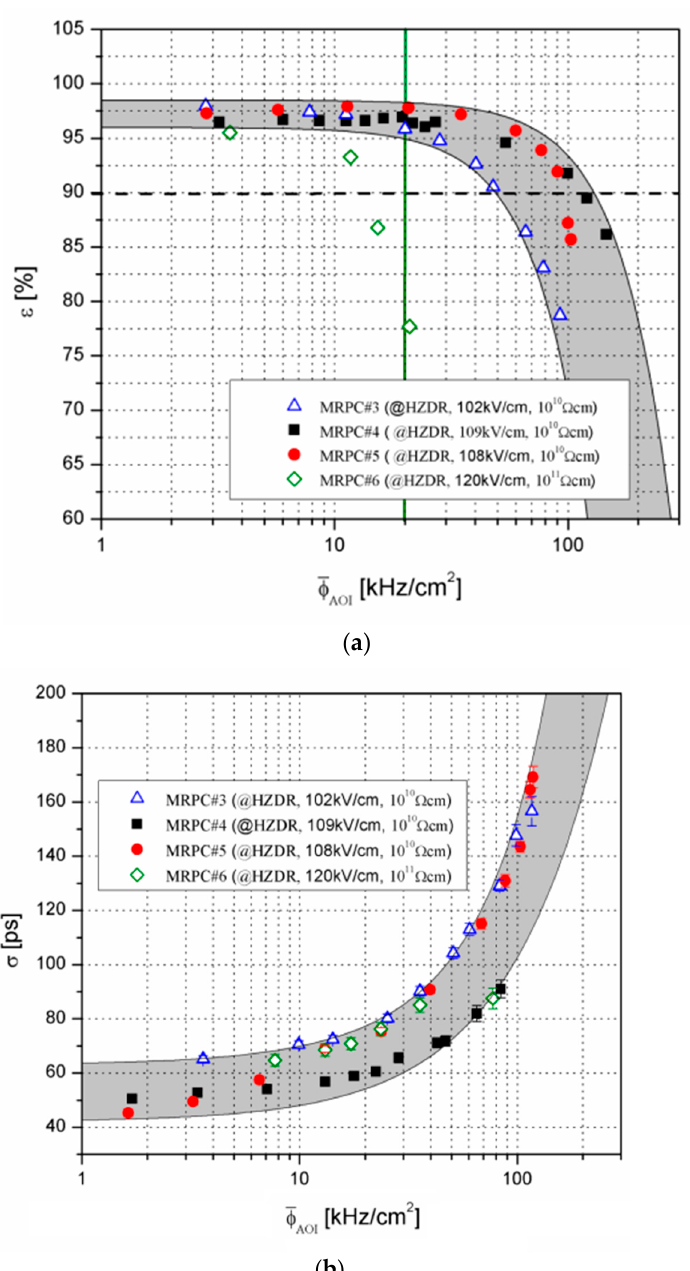
environment. As shown in Figure 6, at the rate of 70 kHz/cm 2 , the efficiency above 90% and time resolution around 80 ps [66] are achieved.